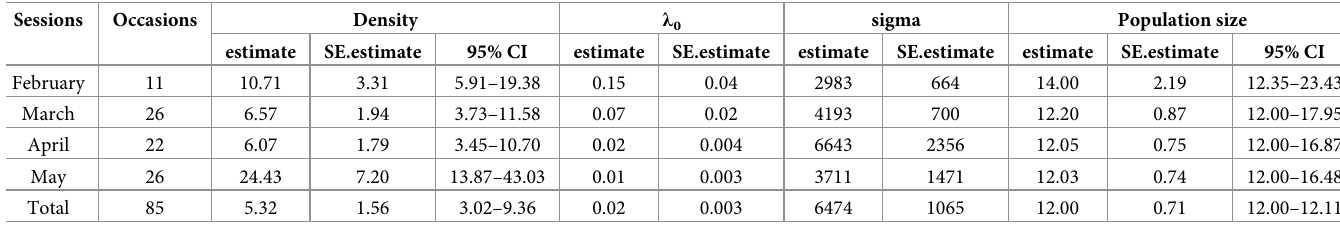
We identified an inverted pyramid age structure for this population: three adult females, three adult males, one subadult male, two juvenile females, two juvenile males and one male calf, with a sex ratio of 1:1.4 using females as a reference (Table 4). The three adult males comprised Table 4. Population density estimation using SECR models for five